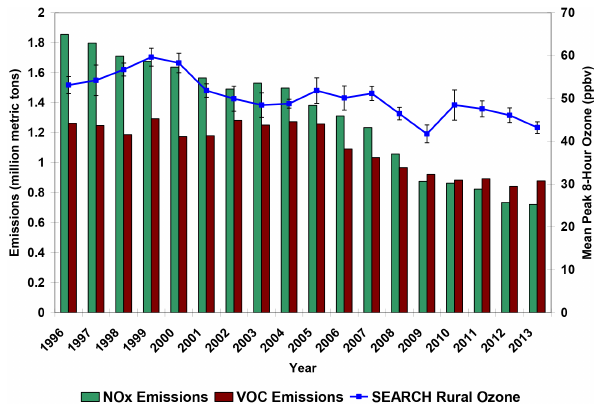
Figure 8. Mean summer (June–August) concentrations of NMOC species at four PAMS sites within the Atlanta metropolitan area. South DeKalb and Tucker are urban sites; YRK is considered an “upwind” non-urban site, while Conyers is a suburban (semi-rural) “downwind” site. (Note: 2012 only July data are available; 2013 only YRK July data are available).